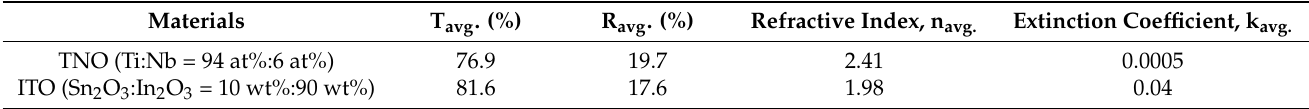
Table 3. Optimum optical experimental result of the respective single-layer ITO and TNO. Materials T avg . (%) R avg . (%) Refractive Index, n avg. Extinction Coefficient, k avg.